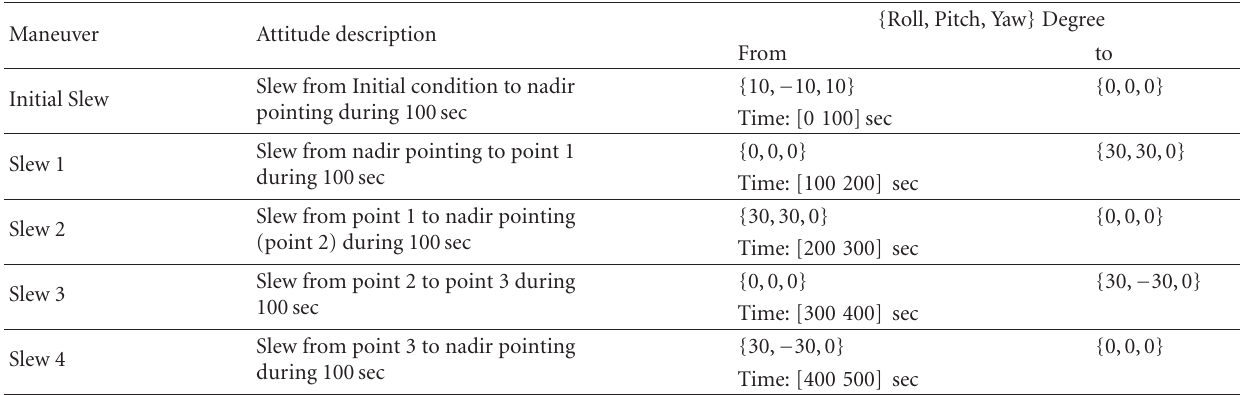
Table 1: Mission sequence for stereoimaging.